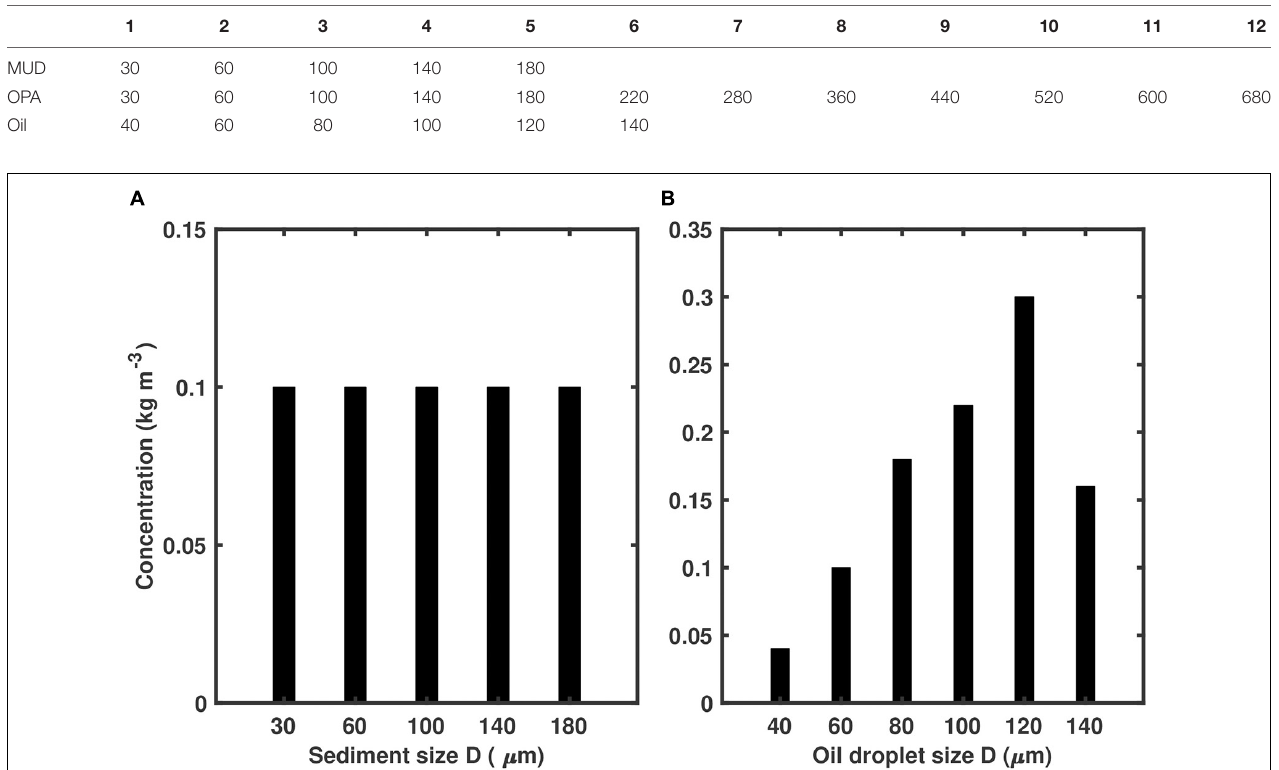
FIGURE 2 | Initial size mass concentration distributions for OPAMOD simulation of (A) sediment particles, and (B) oil droplets.